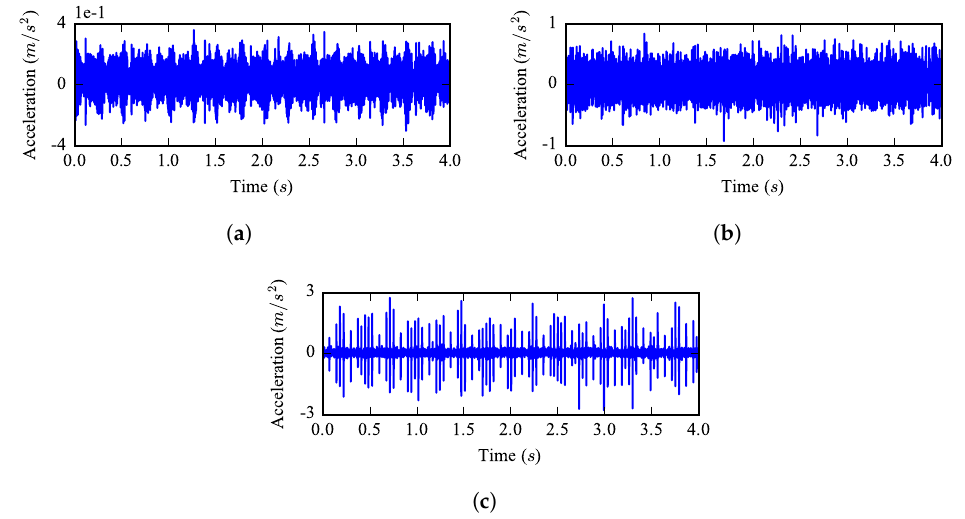
Figure 13. Envelope spectrum of the experimental ring vertical acceleration of the ( a ) healthy gear, ( b ) half tooth breakage fault gear and ( c ) the whole tooth breakage fault.